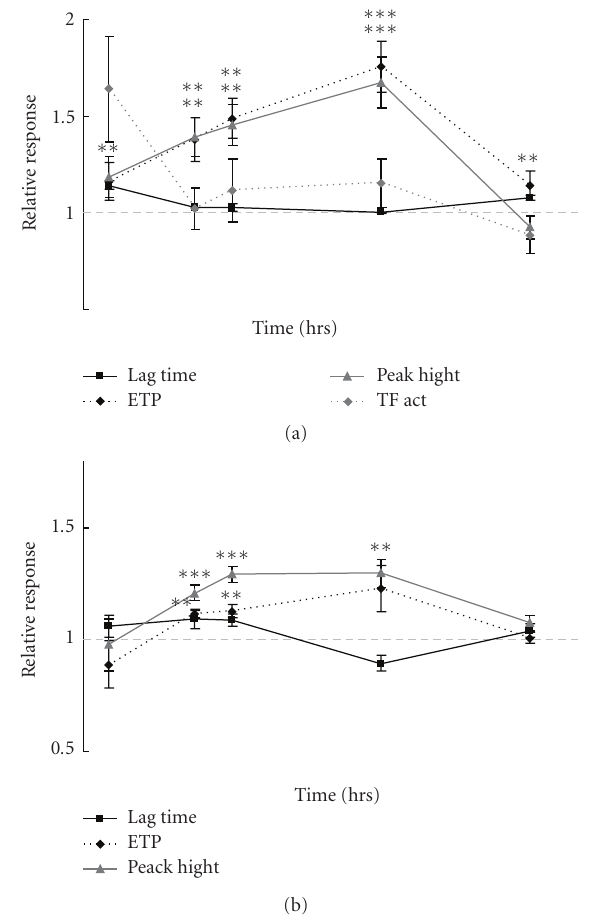
Figure 2: Relative response of TF activity (only in lung tissue), thrombogenicity lag time, ETP, and peak in lung homogenate tissue (a) and in plasma (b) at various time points ( t = 4, 18, 24, 48 and 72h) after termination of a 2 h exposure of rats ( n = 10 per time point and exposure) to DEE. (Uric acid response is indicated by right y -axis). Relative response is defined as the mean value of the DEE exposed group divided by the mean value of the sham exposed group at the same time point. Error bars indicate the standard error of the mean, corrected for the error introduced by the normalization. ∗ , ∗∗ , ∗∗∗ significantly di ff erent from control at P < . 05, < .01, < . 001,